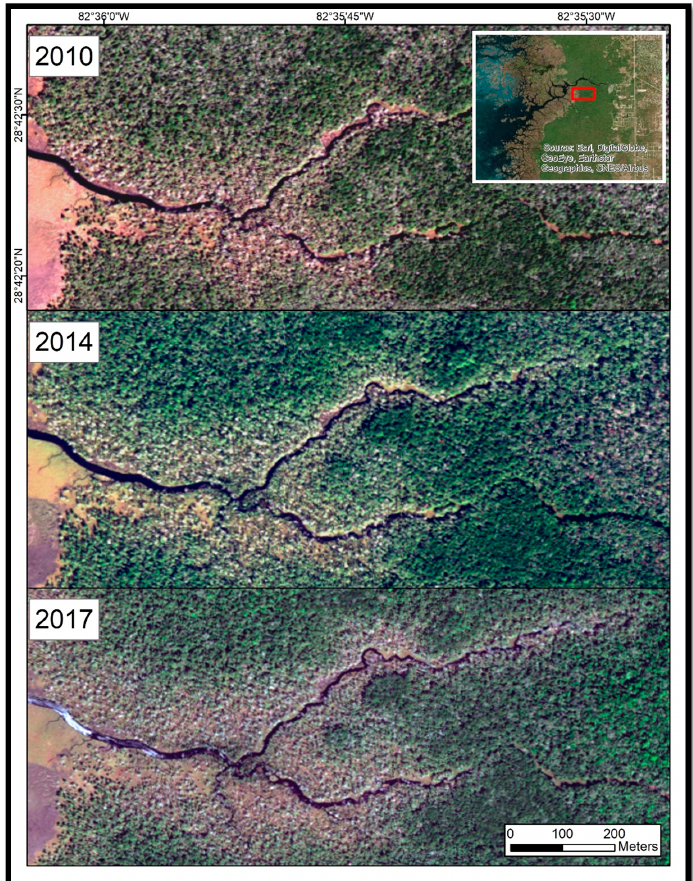
Figure 10. WorldView-2 imagery (copyright 2010 Digital Globe, Inc.) time series of coastal forest loss along a Chassahowitzka River tributary, from 2010 to 2017, indicating further decline and no apparent recovery after initial 2010 and 2011 cold events.